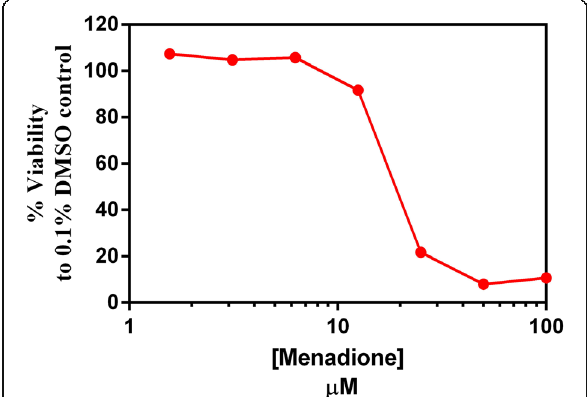
Fig. 3 Concentration-response curve of the toxicity of Menadione on Hepa-1c1c7 cells. Cells were cultured and treated with MD (1.5 – 100 μ M) for 24 h and then assayed using SRB cytotoxicity assay as described in the Experimental section, each data point represents means of Octuplet well treatments